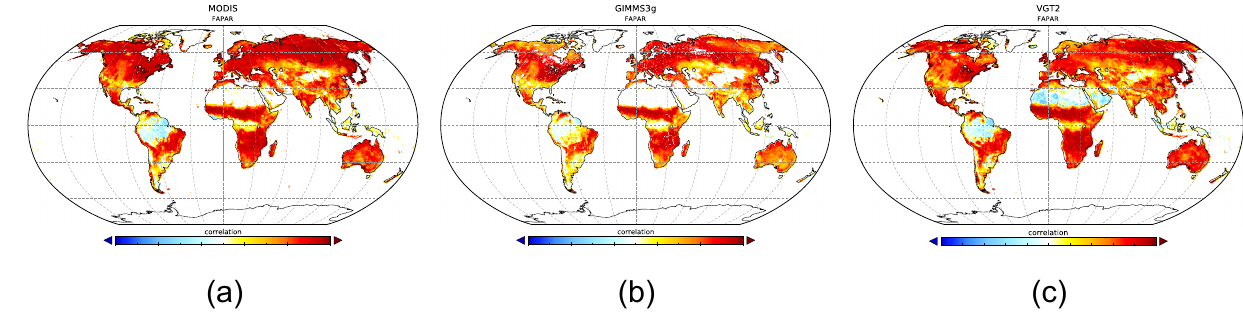
Figure 10. Evaluation of FAPAR for different data sources: MODIS (a) , GIMMS (b) , and VGT2 (c) .